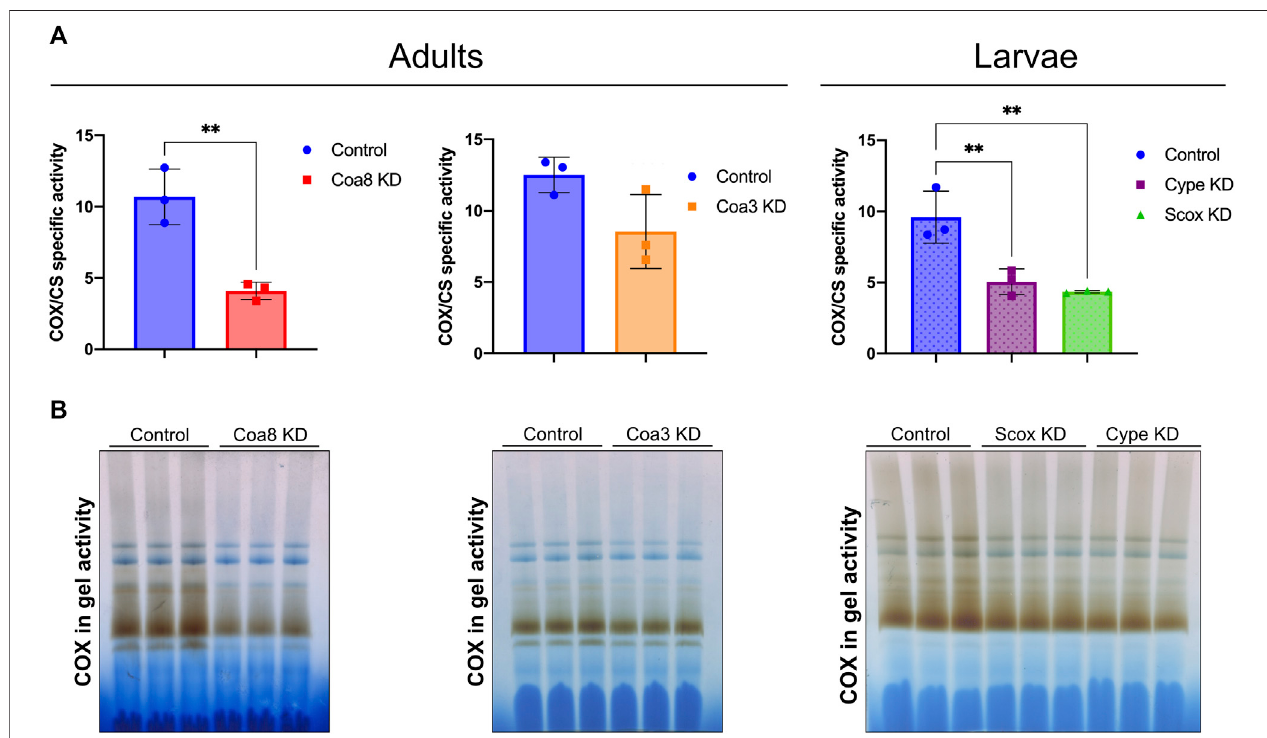
FIGURE1| ExtentoftheCOXde fi ciencyin D.melanogaster KDmodels. (A) SpectrophotometrickineticenzymeactivitymeasurementsofCOXactivity,normalized by the activity of citrate synthase (COX/CS) in mitochondrial fractions from control adults (solid blue bars), Coa8 KD adults (solid red bars), Coa3 KD adults (solid orange bars), control larvae (dotted blue bars), cype KD larvae (dotted purple bars) and Scox KD larvae (dotted green bars). The symbolsrepresent the individual values of each replicatemeasurement,andthebarsrepresentthemean±SD.Thestatisticalsigni fi cancewascalculatedusingStudent ’ st-testfortheadultpairwisecomparisons, and one-way ANOVA with Tukey ’ s multiple comparisons test for the three larvae groups (** p ≤ 0.01). (B) COX in gel activity assays performed in DDM-solubilized mitochondrial samples, separated through blue-native electrophoresis gels, from three independent replicates for each of the indicated experimental group.